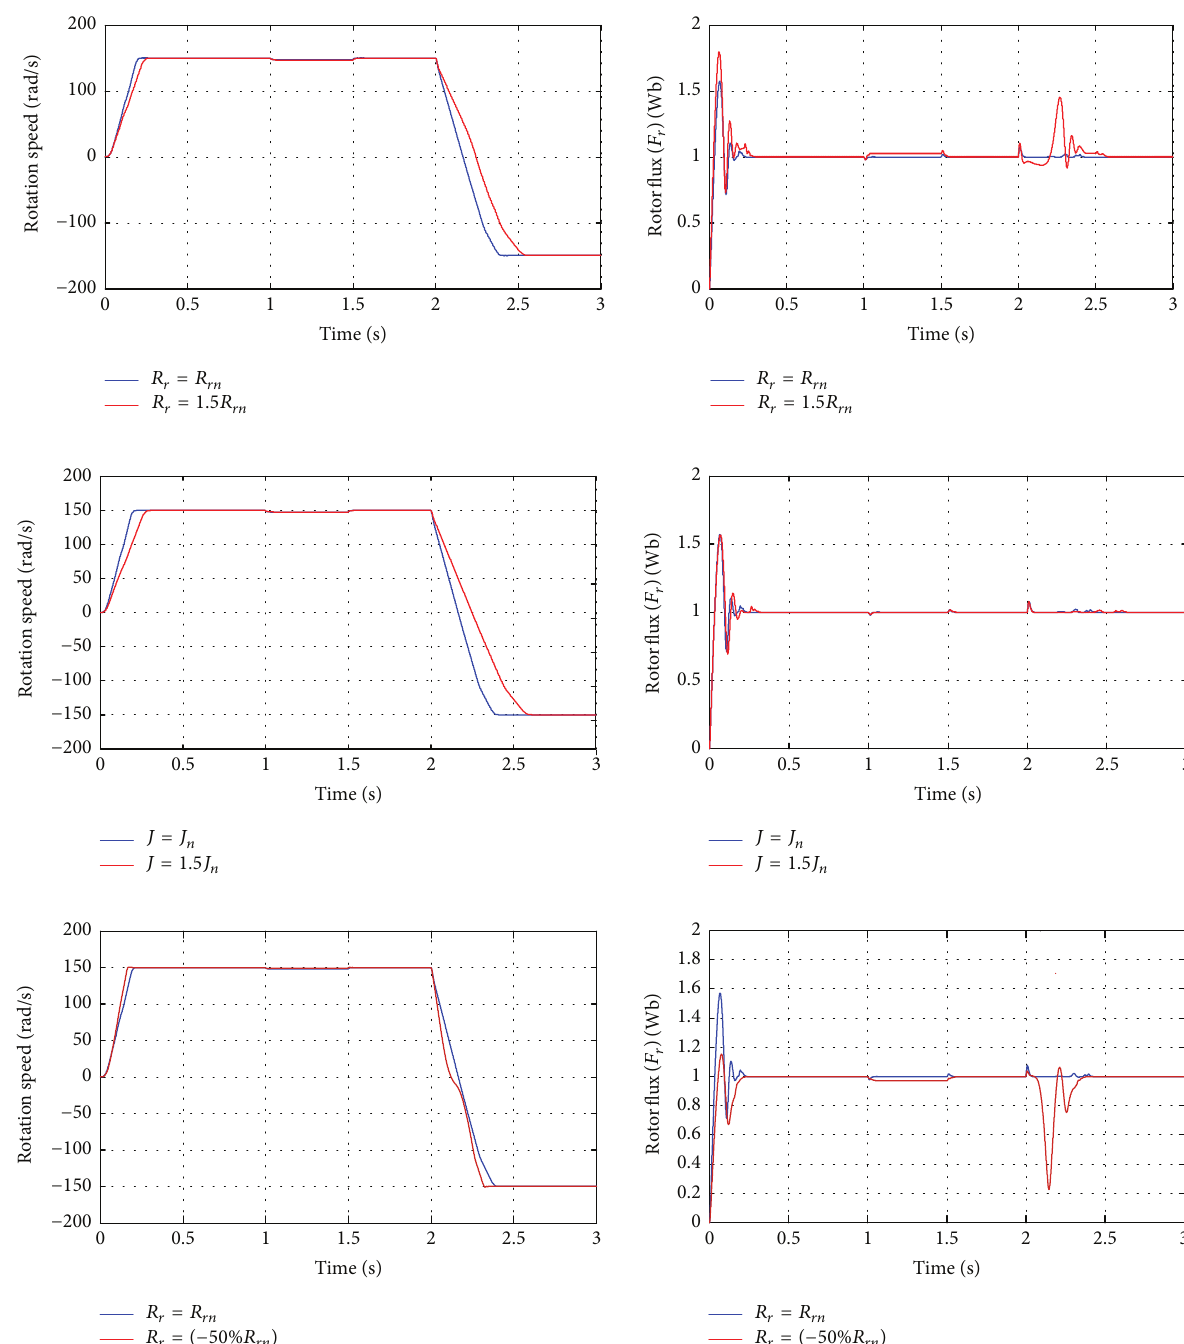
Figure 10: Control by neuronal controller with varying